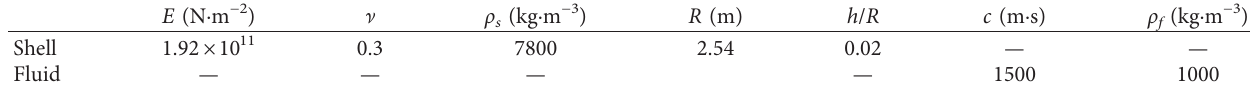
Table 1: Physical parameter of the shell and fluid.